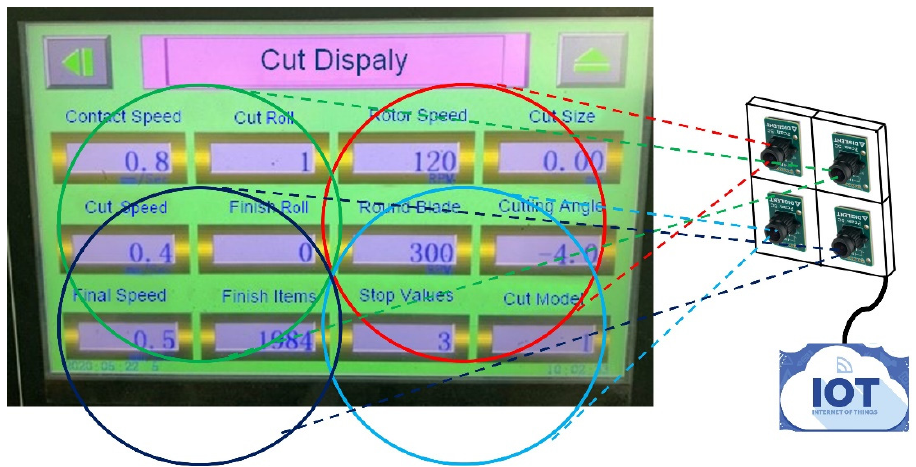
Figure 6. Array camera of the end device in IoT.